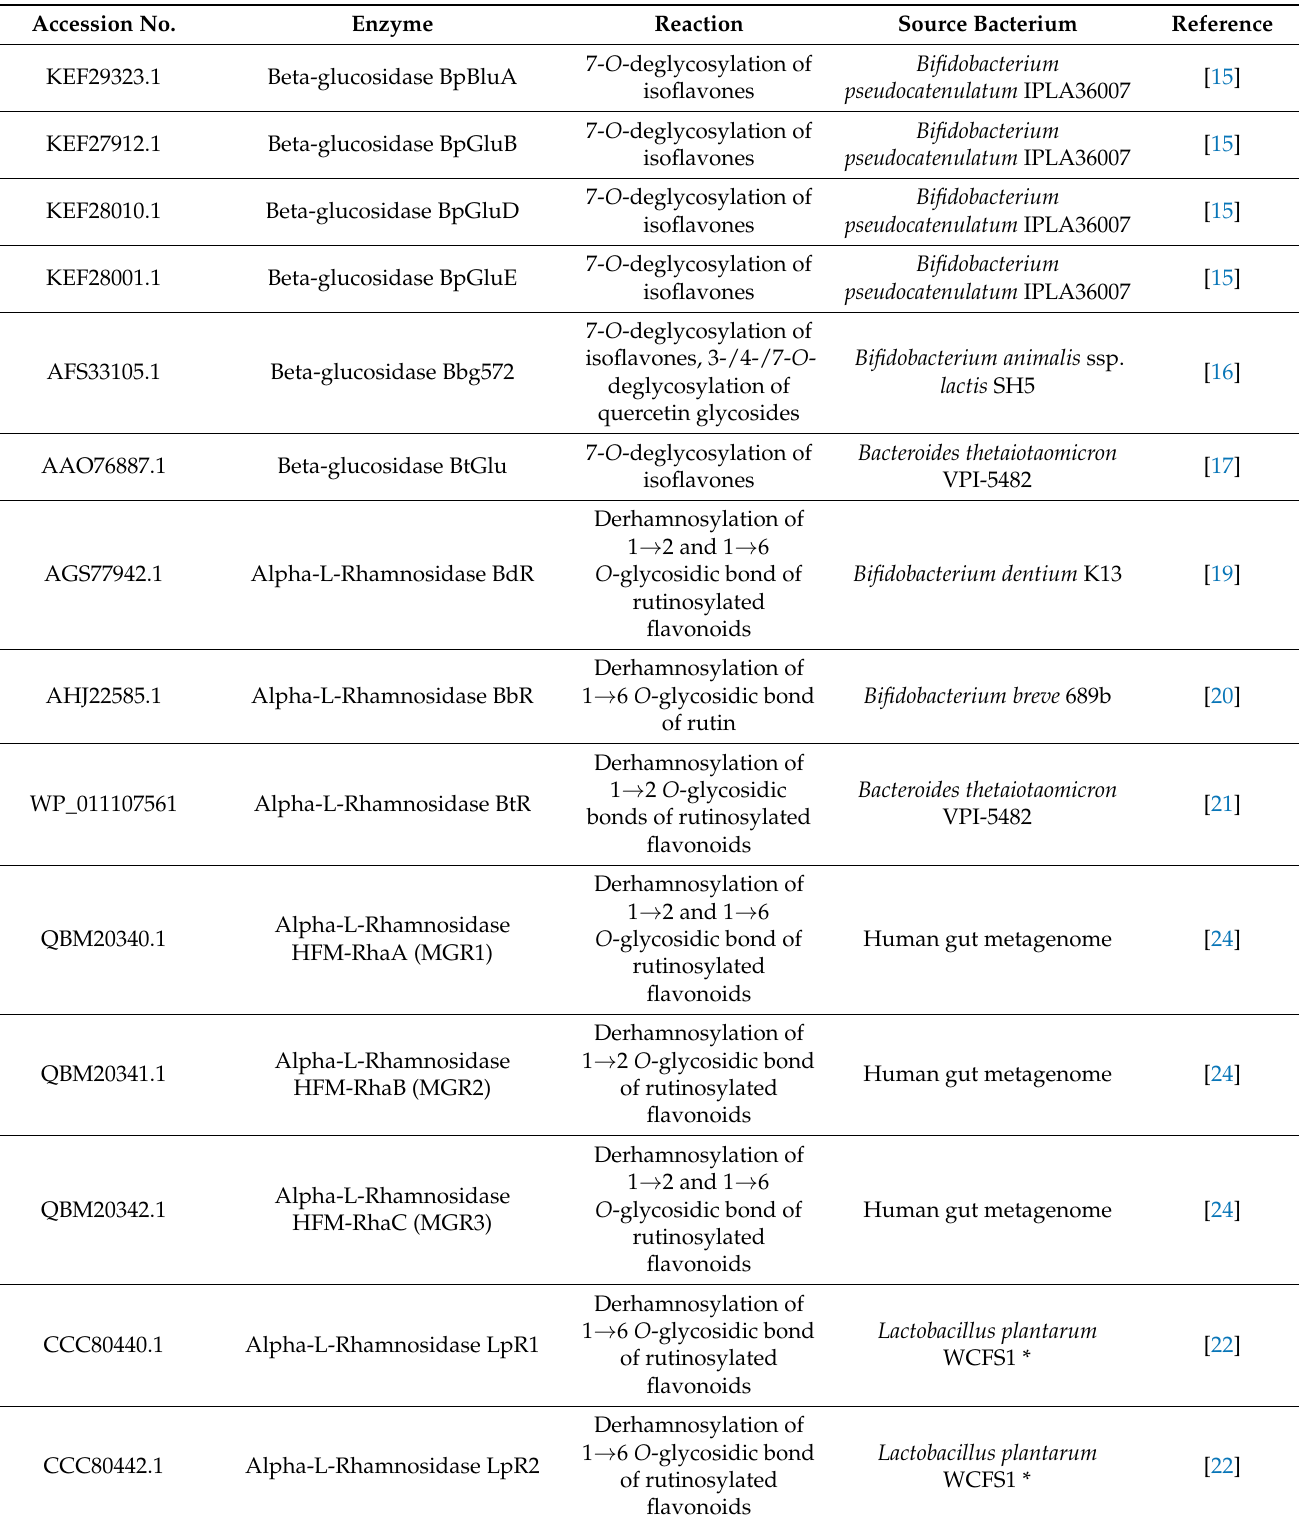
Table 1. Characterized flavonoid-modifying enzymes of human gut